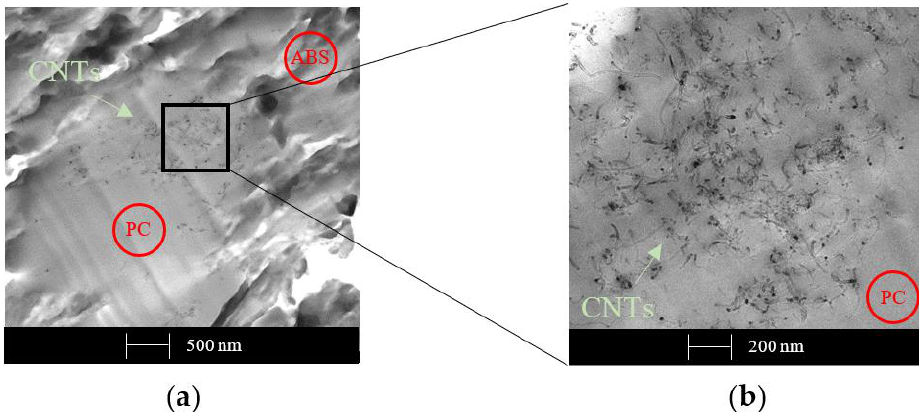
Figure 13. TEM micrographs of sample with 1 wt. % of CNTs obtained by melt extrusion method.